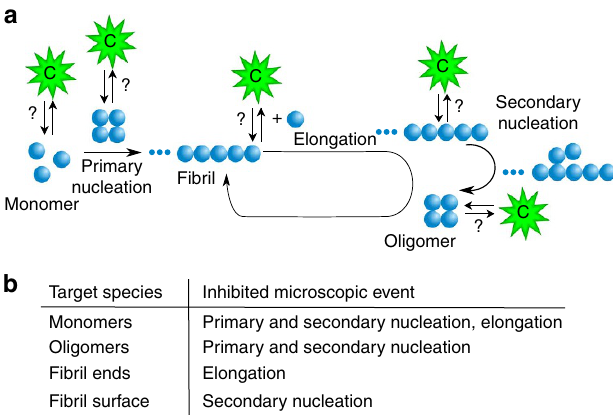
Figure 1 | Schematic illustration of an aggregation reaction network. ( a ) This network is made up by the microscopic steps in the aggregation mechanism of an amyloidogenic protein (blue), and the several possible interactions between a molecular chaperone (green) and the different protein species present in the system; ( b ) Depending on the target species, different microscopic steps can be